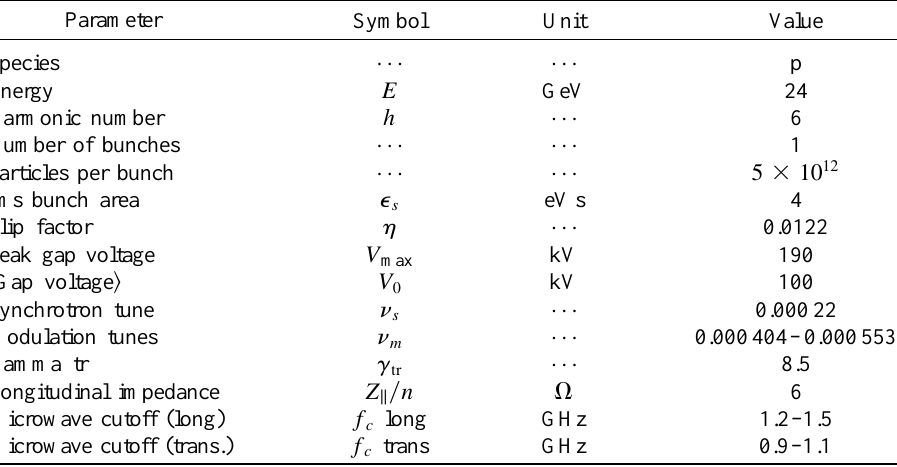
TABLE I. Parameters in the AGS